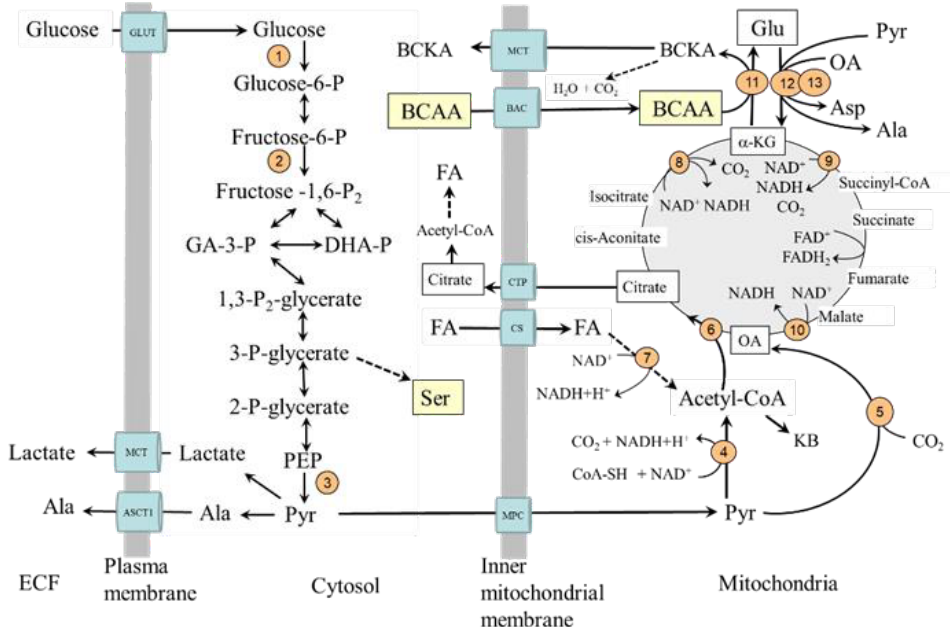
Figure 1. Glycolysis and its relationship to serine synthesis, beta-oxidation, citric acid cycle, and